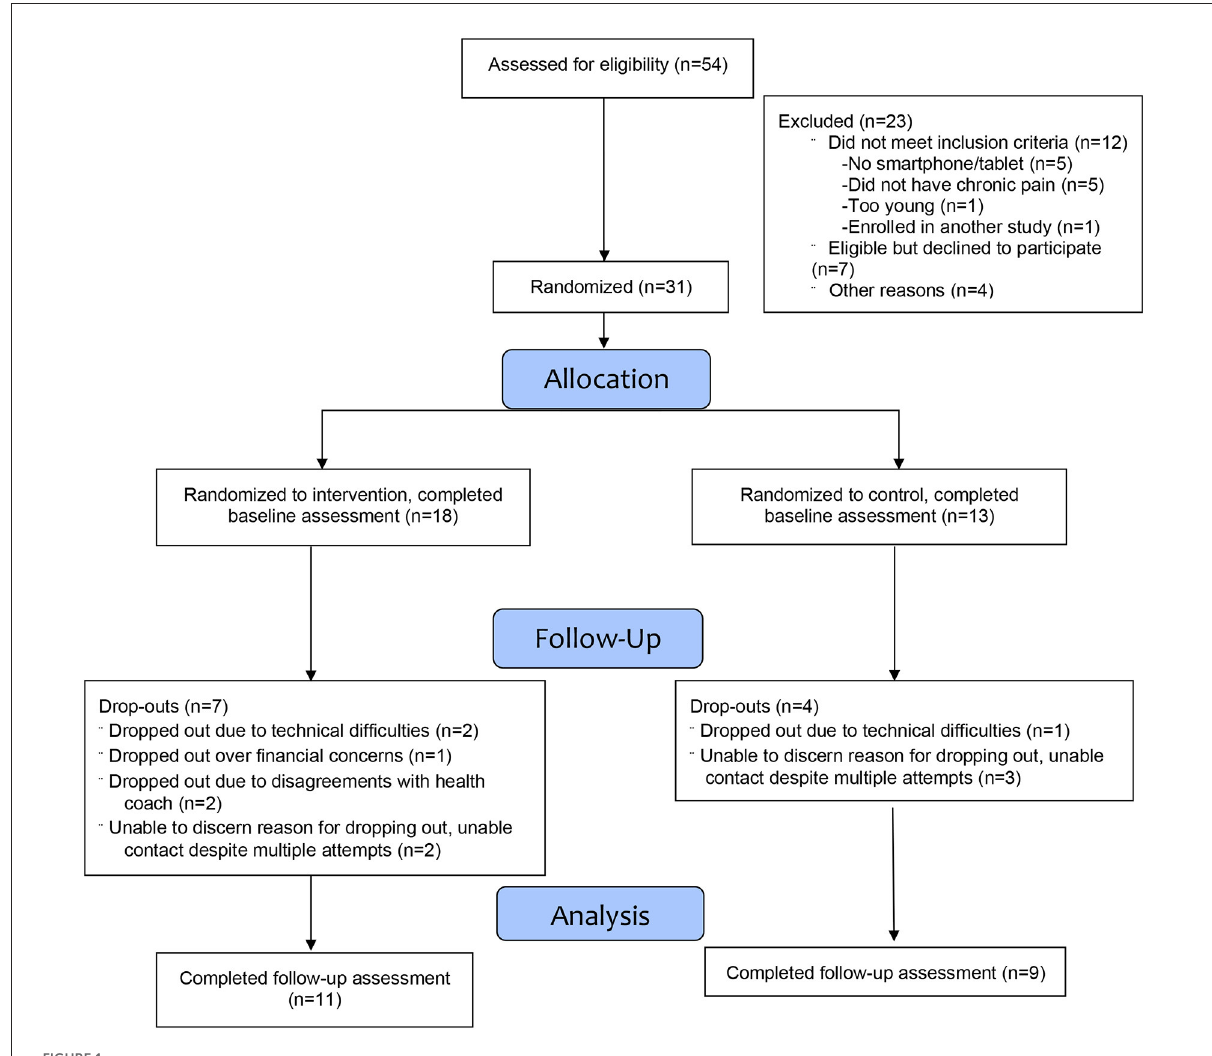
FIGURE1 Enrollment and randomization flow